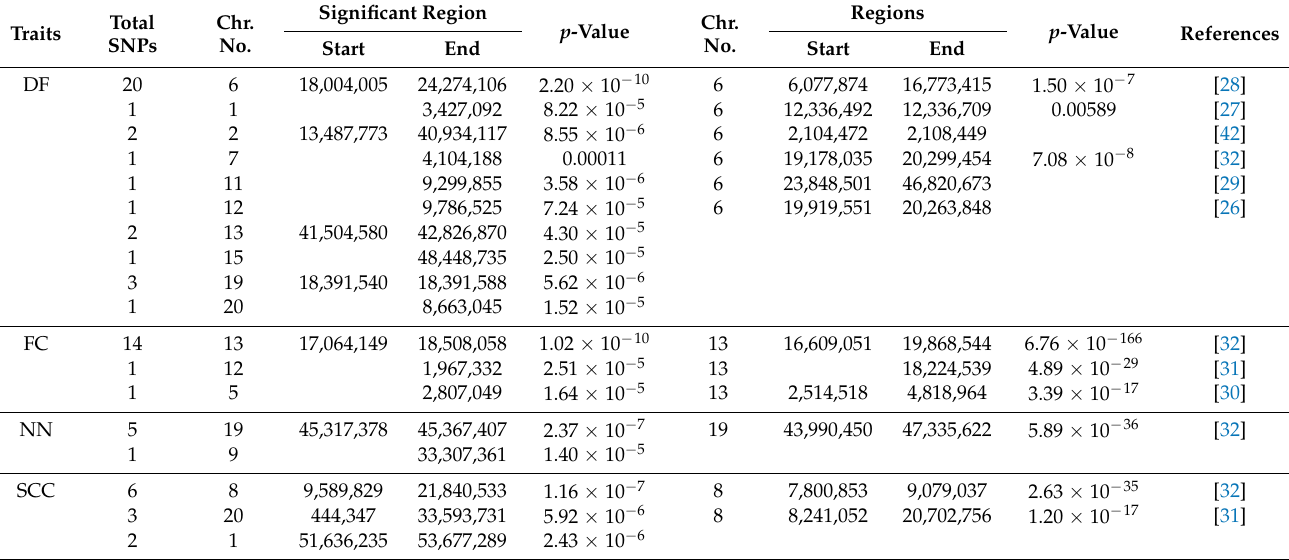
Table 2. Details regarding the loci associated with different traits revealed by a GWAS of 192 soybean MDP lines.